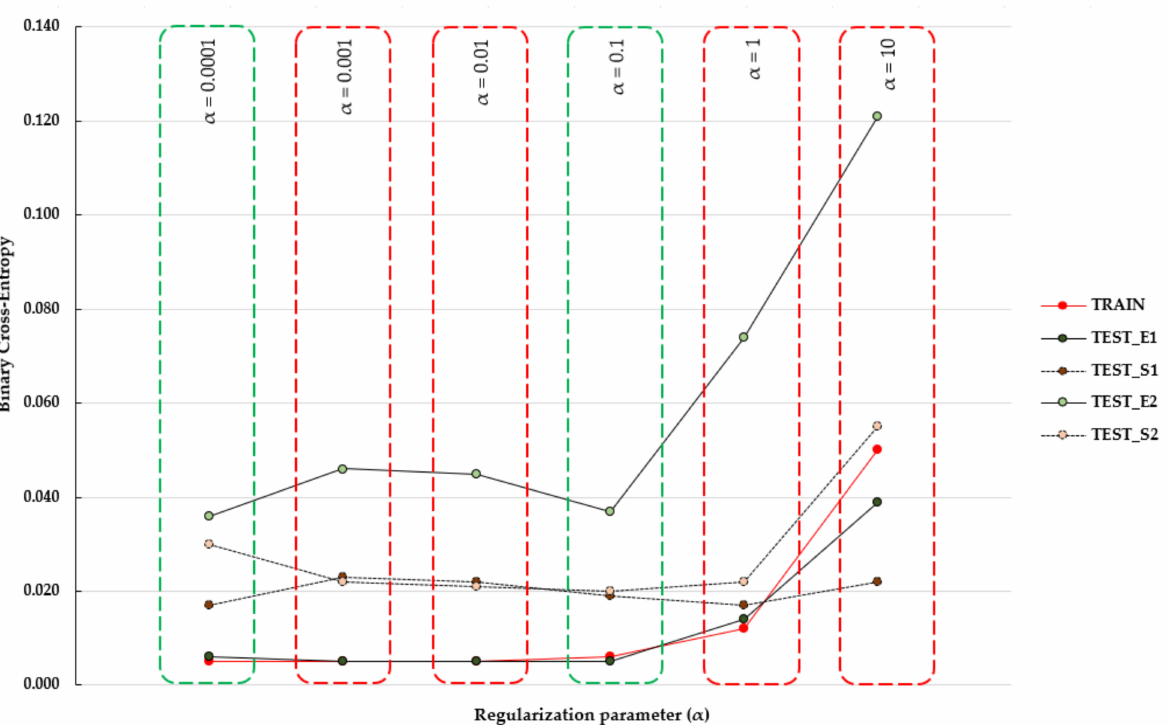
Figure 3. Log loss (binary cross-entropy) of the training and testing data as a function of the regularization parameter term ( α ). Legend: TRAIN—fused training dataset, TEST_E1 and TEST_E2—testing datasets collected on the tool’s engine, TEST_S1 and TEST_S2—testing datasets collected on the tools’ transmission shaft. Note: Values shown are computed by using Equation (3), based on the normalized data (Equation (2)); models retained for further analysis are bordered by green dashed